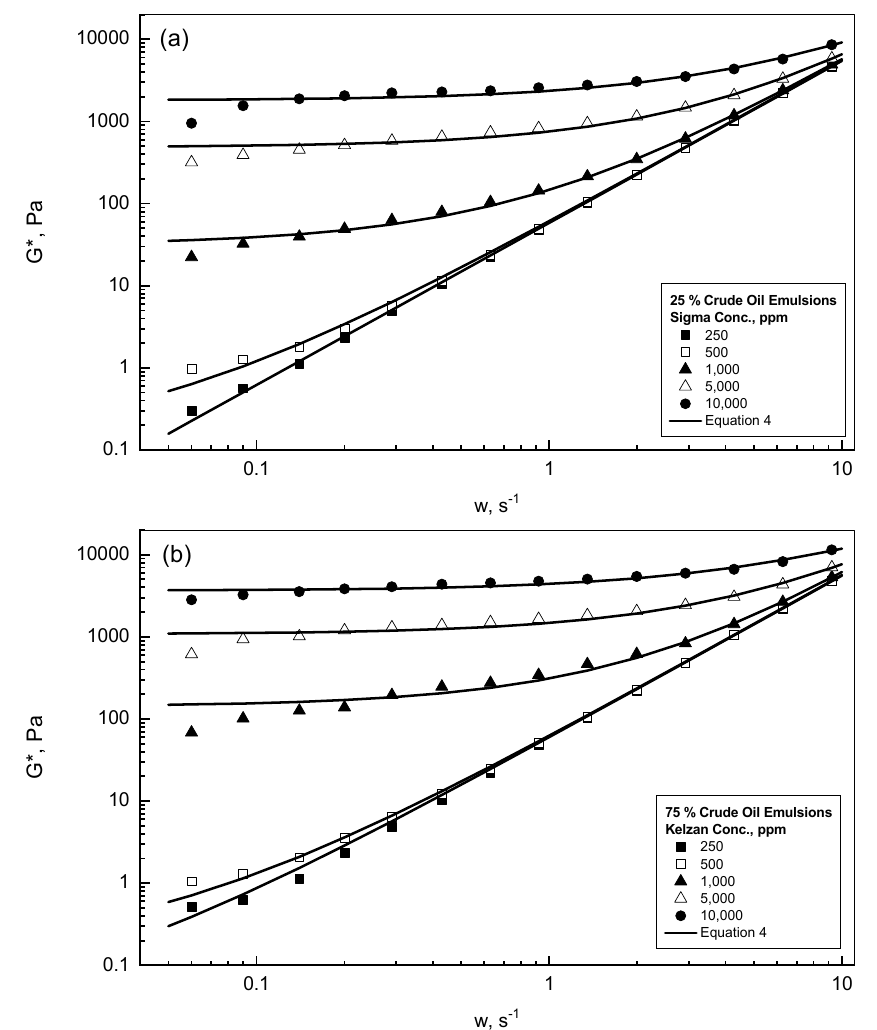
Figure 1. G* different behaviors of oil-gum emulsions. ( a ) 25% crude oil emulsions; ( b ) 75% crude oil emulsions. Table 1. Crude oil-gum emulsion critical frequency w c . Gum Conc., ppm